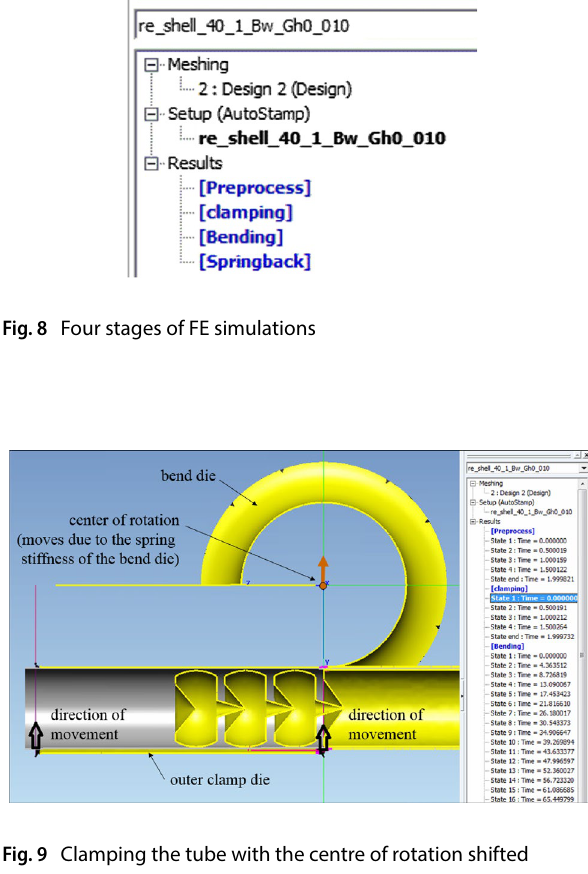
Fig. 9 Clamping the tube with the centre of rotation